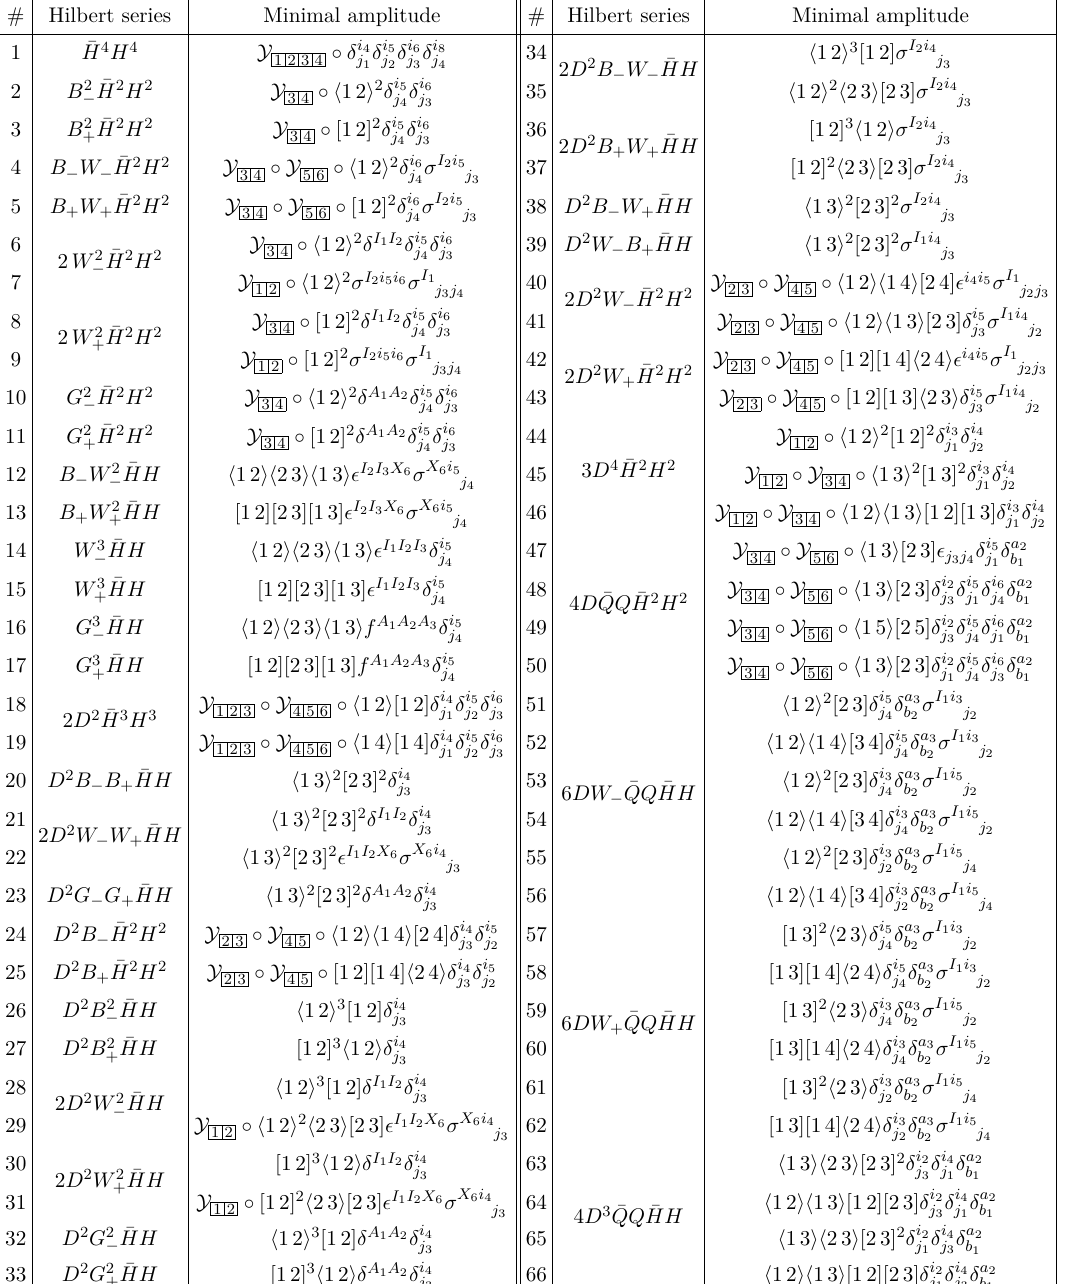
Table 2 . The table shows all the dimension-8 operators, their multiplicity and a set of independent minimal